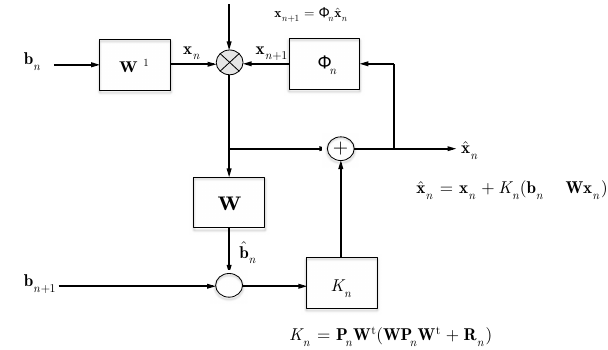
Figure 9. Schematic description of Kalman filtering.